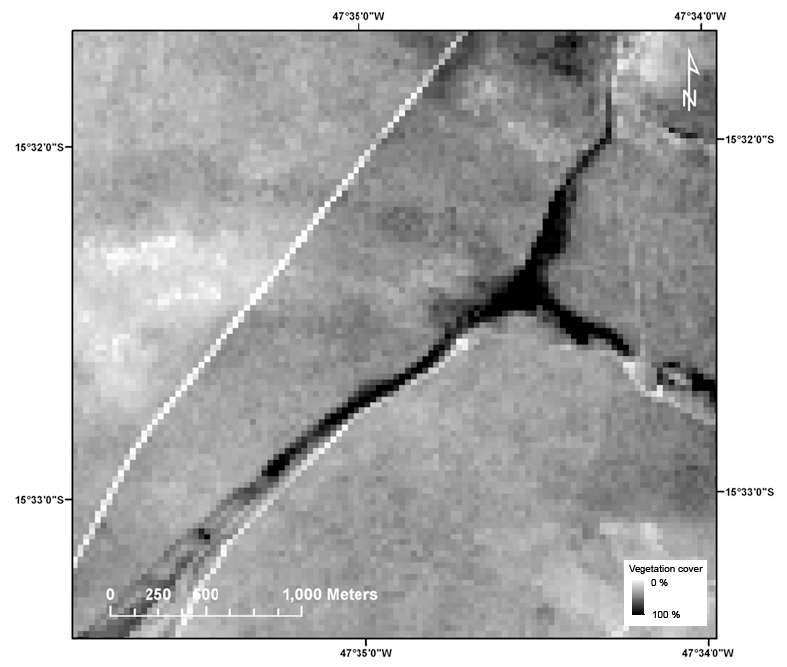
Figure 6. Spatial gradients of Cerrado vegetation cover, as captured by the panchromatic band of the Earth Observing One (EO-1) Advanced Land Imager (ALI) sensor (resampled to a g.s.d. of 30 m). In this image, brighter pixels correspond to low vegetated areas (bare soil and grasslands) where darker ones correspond to more densely vegetated areas (dense savannah woodlands and riparian galleries). The gradual transitions from bright to dark pixels illustrate the described vegetation